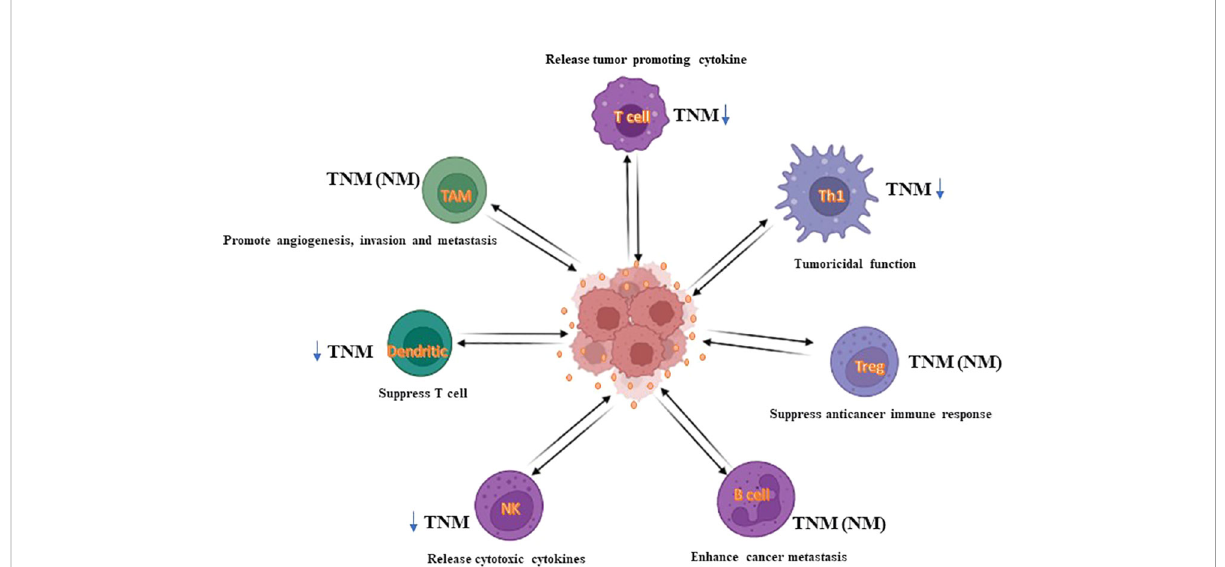
FIGURE 6 The impact of immune in fi ltrates on CRC. In CRC, immune in fi ltrates can impact CRC cell death, either directly or via tumoricidal T cells (TCT), and consequently affect tumor progression. For example, cytotoxic T cells, macrophages, and NK cells can exert a cytolytic effect on CRC cells. For other populations of cells, such as Treg, B cells, dendritic cells, or M2-like macrophages, generally impact CRC cell death by mediating the tumoricidal activity of TCT cells. Herein, Treg, regulatory B cells, immature dendritic cells, and macrophages enable TCT cells to be exhausted, thus causing substantial progression in CRC tumors. Accordingly, immunoscore system using immune cells could deliver insights into a novel liquid biopsy approach as a diagnostic